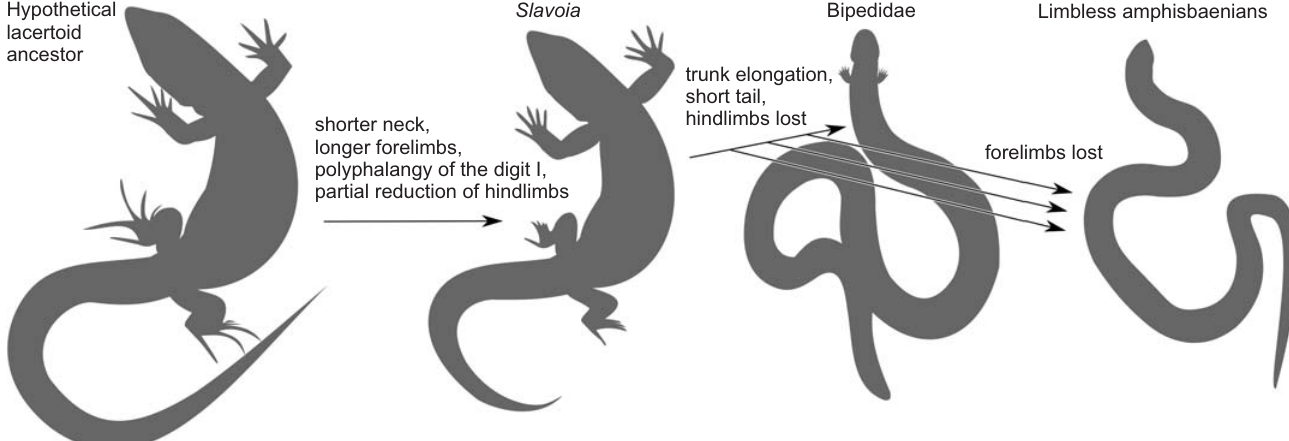
Fig. 15. Sequence of evolutionary changes in the amphisbaenian body plan proposed in this work. The phylogenetic relationships are taken from Kearney and Stuart (2004) and Ta ł anda